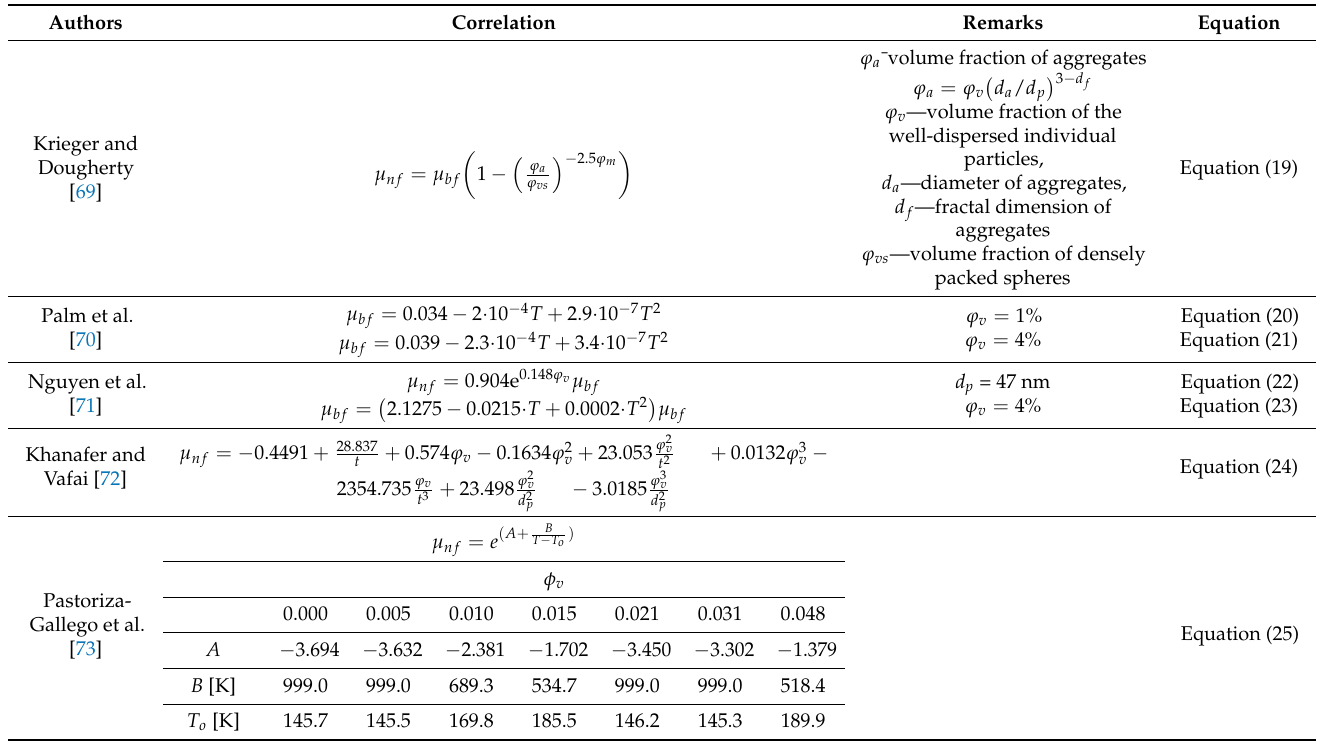
Table 4. Correlations for viscosity of water- Al 2 O 3